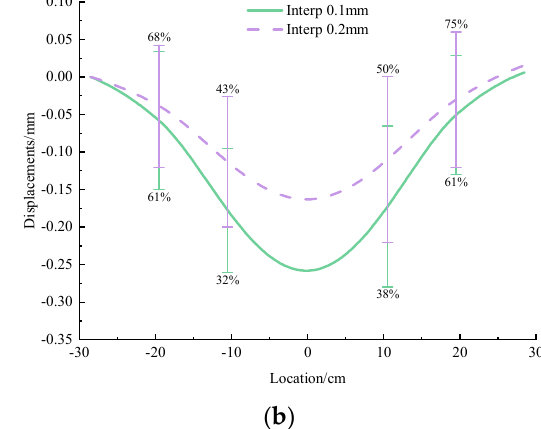
Figure 9. Angle and displacement curve of steel tunnel with 0.1 mm and 0.2 mm thickness under concentrated load. ( a ) Angle. ( b ) Displacement.